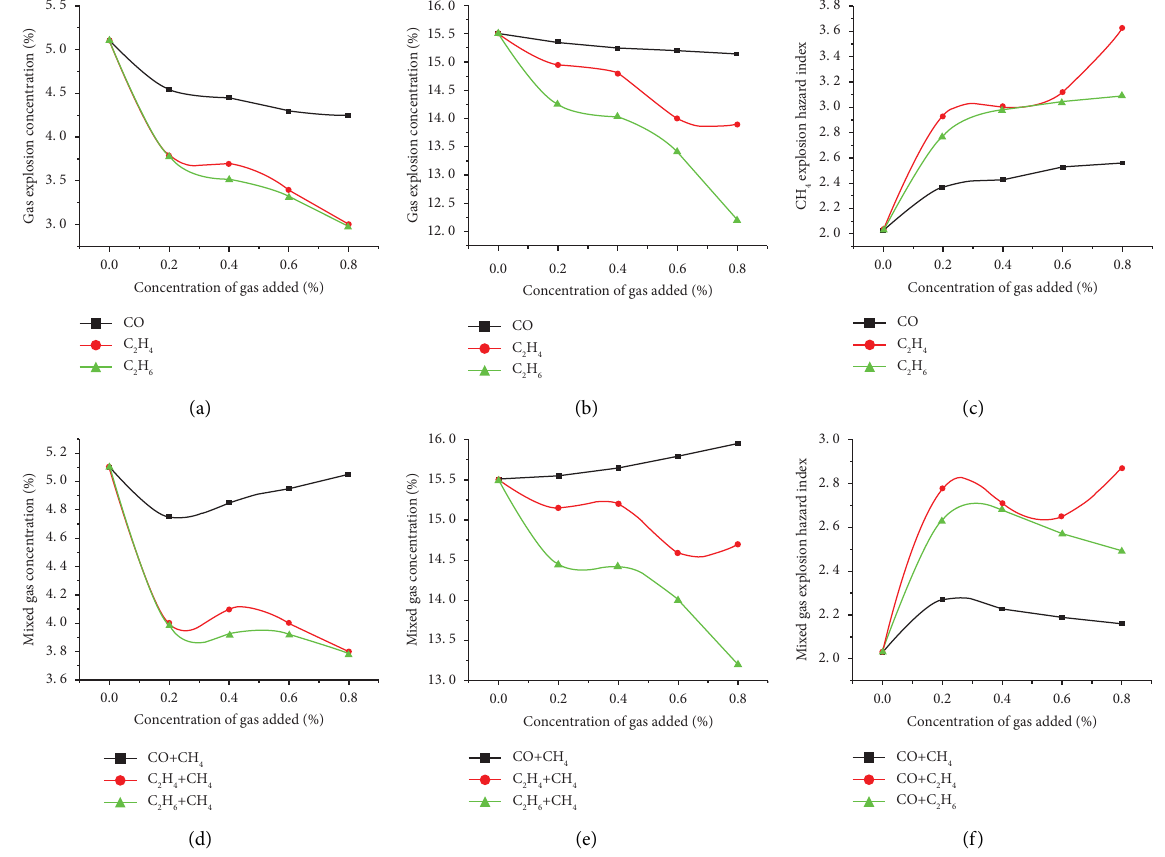
Figure 6: Experimental data analysis: (a) Lower limit of CH 4 explosion, (b) upper limit of CH 4 explosion, (c) CH 4 explosion hazard index, (d) lower limit of mixed gas explosion, (e) lower limit of mixed gas explosion, and (f) mixed gas explosion hazard